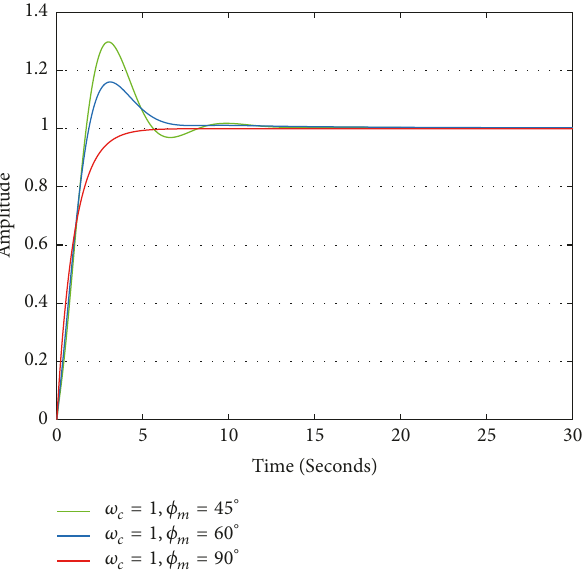
Figure 12: Step responses of 𝑃 1 (𝑠) with different 𝜙 𝑚